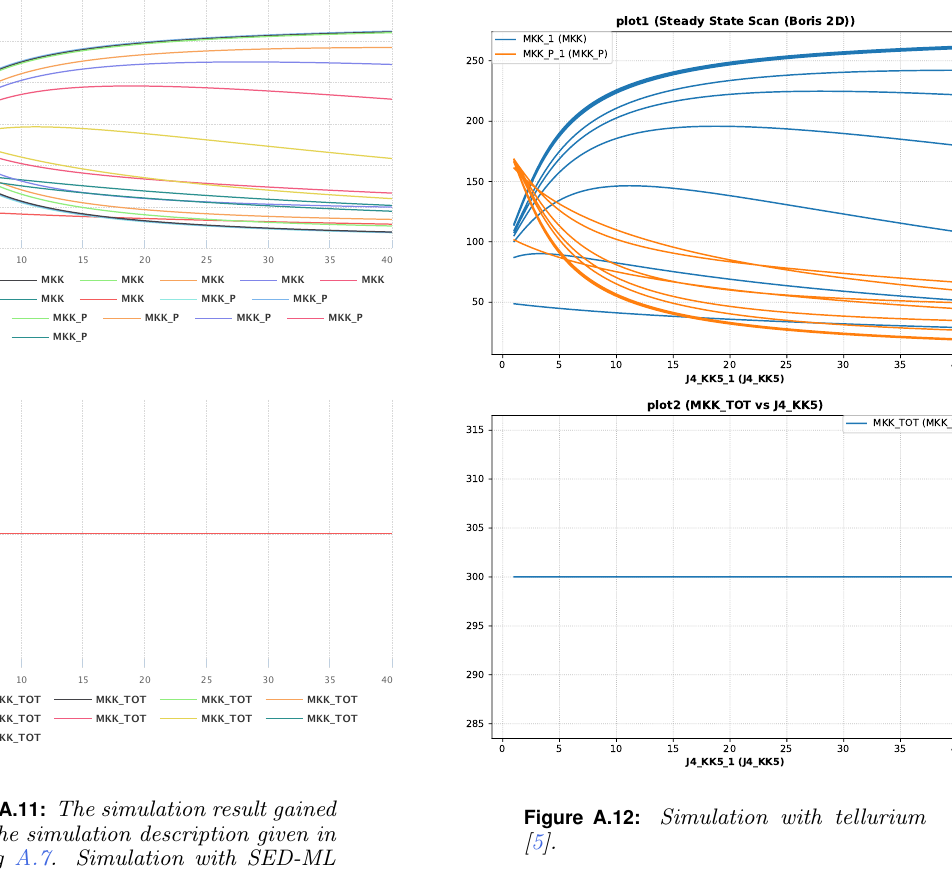
Figure A.12: Simulation with tellurium